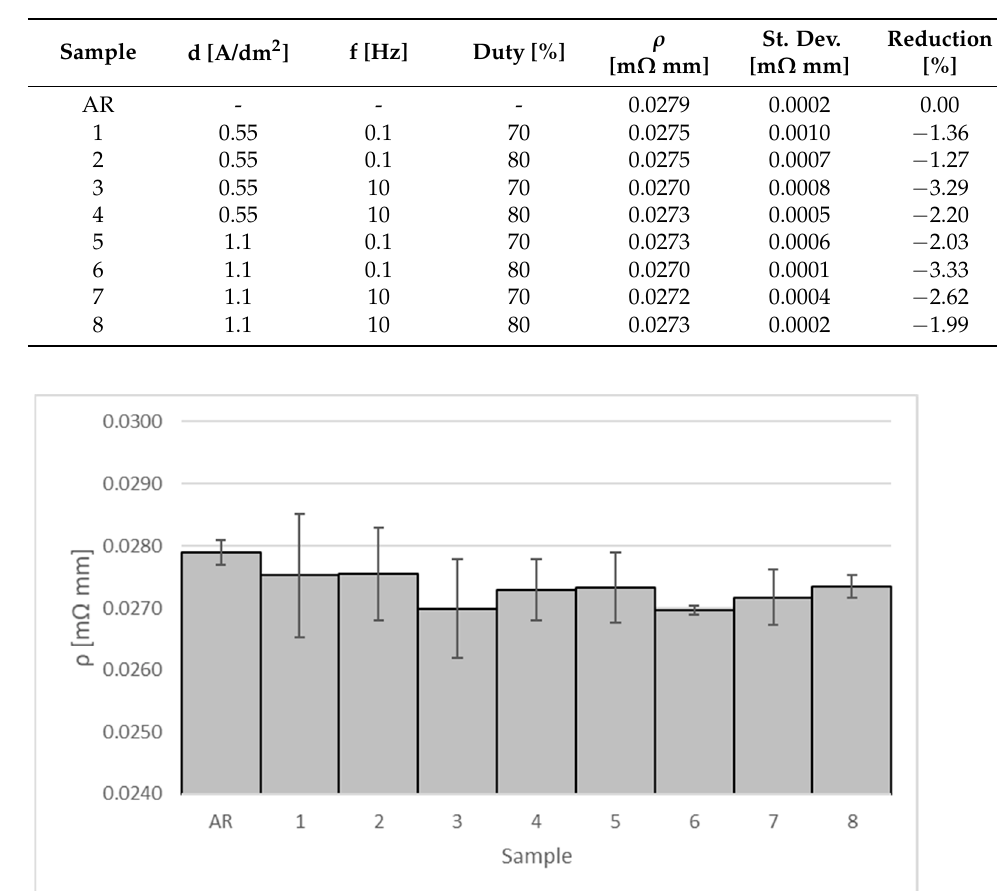
Figure 8. Electrical resistivity of the coated samples.